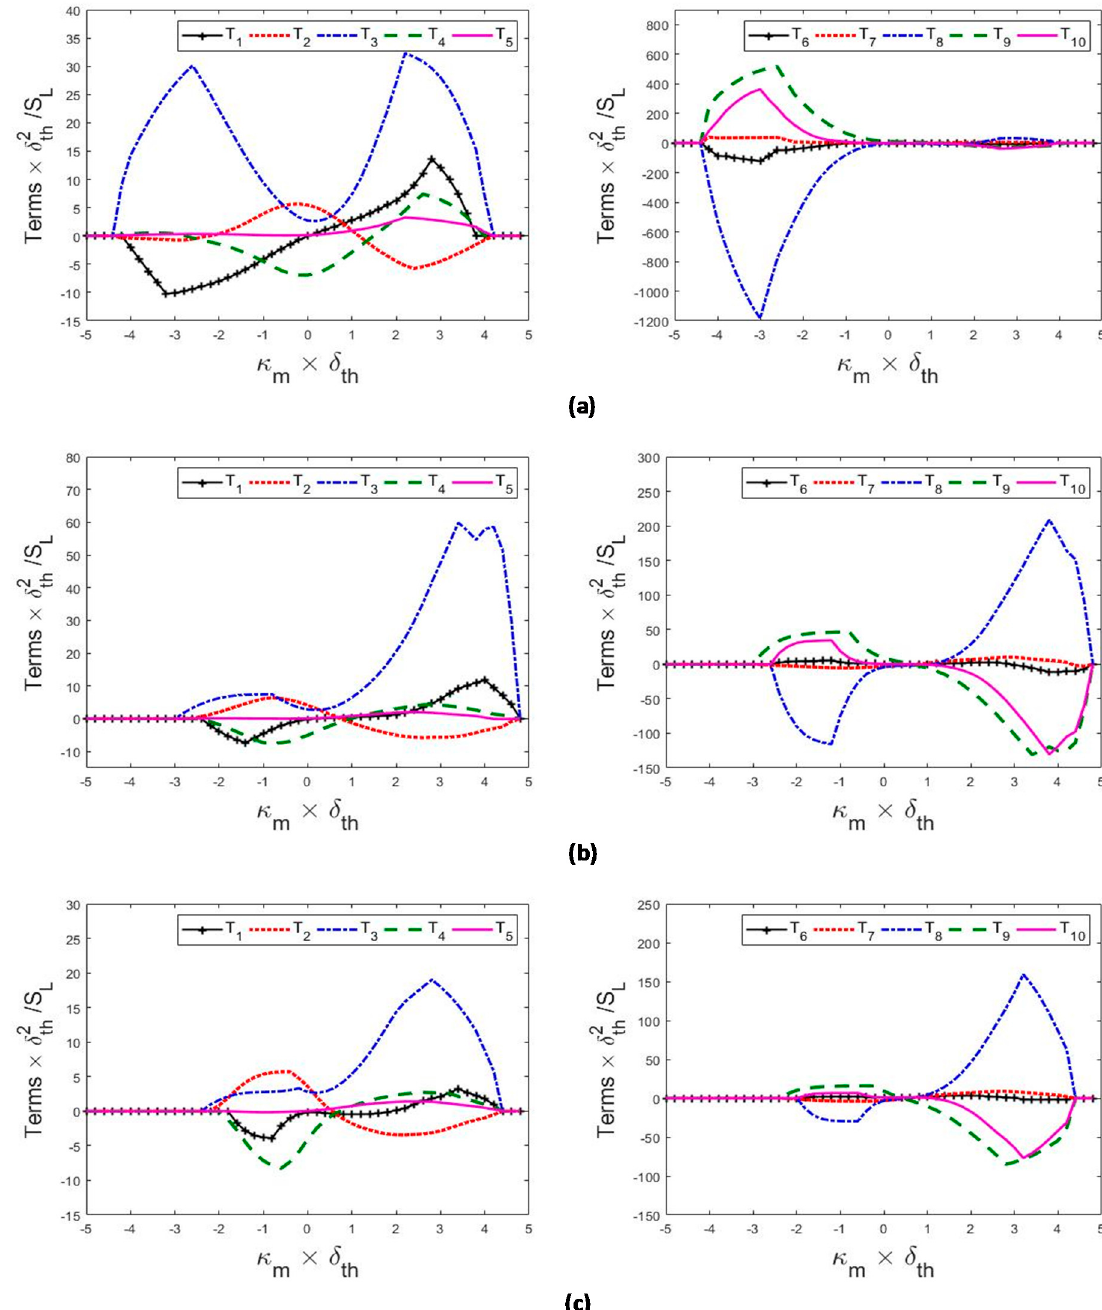
Figure 5. Profiles of the normalised mean values of the fluid flow induced terms (i.e., 𝑇 (cid:2869)(cid:2879)(cid:2873) × 𝛿 (cid:3047)(cid:3035)(cid:2870) /𝑆 (cid:3013) ) (left column) and flame propagation induced terms (i.e., 𝑇 (cid:2874)(cid:2879)(cid:2869)(cid:2868) × 𝛿 (cid:3047)(cid:3035)(cid:2870) /𝑆 (cid:3013) ) (right column) of the curvature transport equation conditional upon normalised curvature 𝜅 (cid:3040) × 𝛿 (cid:3047)(cid:3035) on the 𝑐 = 0.8 isosurface for cases ( a – c ) Le = 0.8, 1.0 and 1.2.